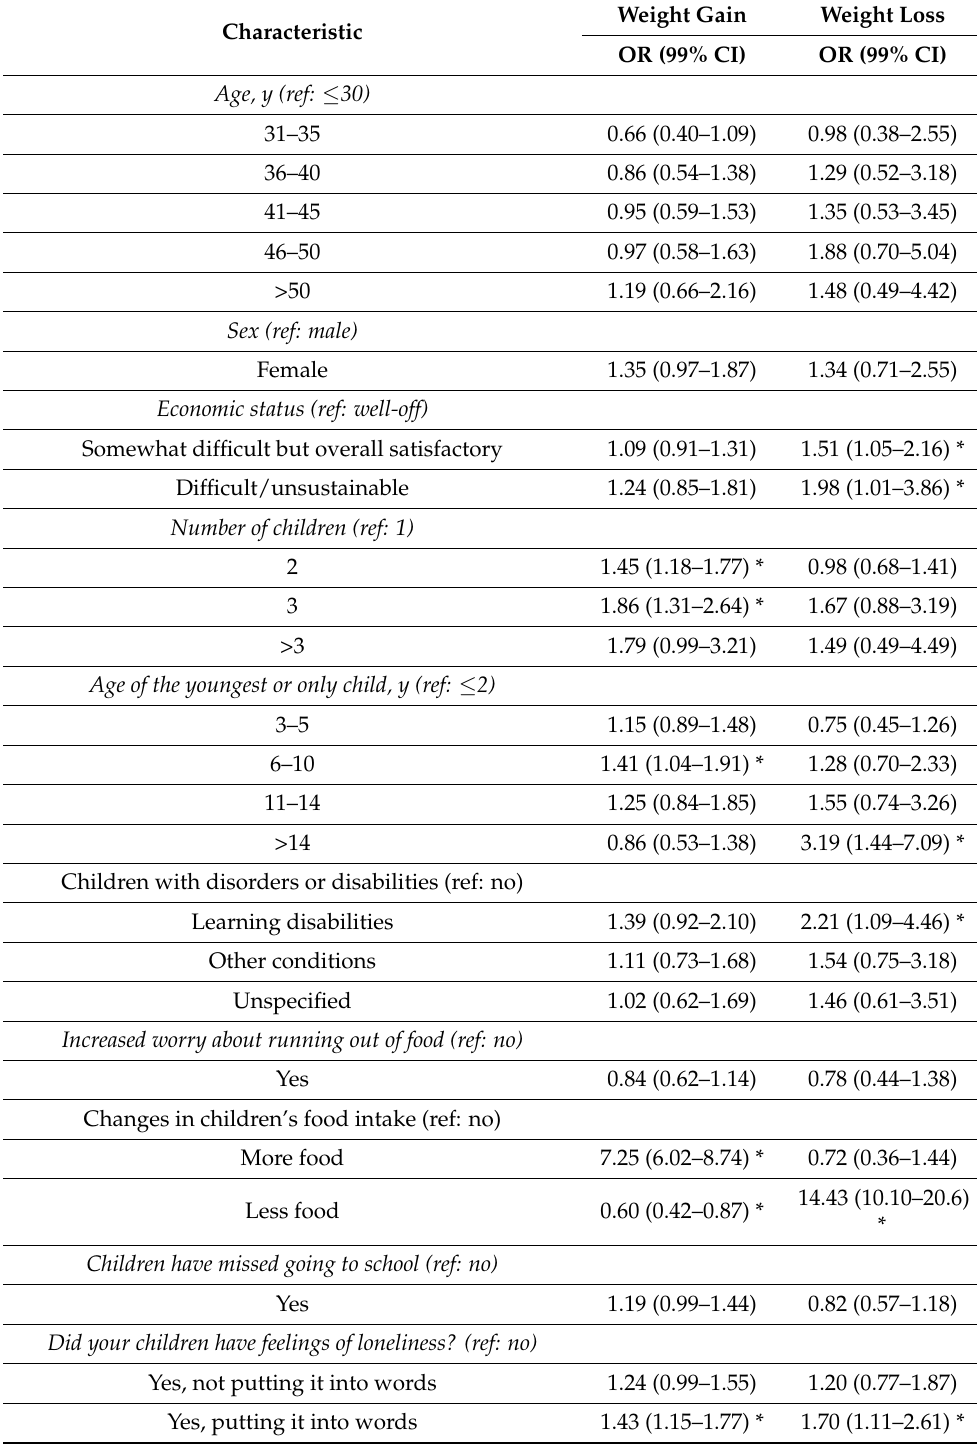
Table 5. Multivariable logistic regression analysis of increased and decreased vs. unchanged chil- dren’s body weight after COVID-19 outbreak. Results are presented as odds ratios (ORs) and 99% confidence intervals